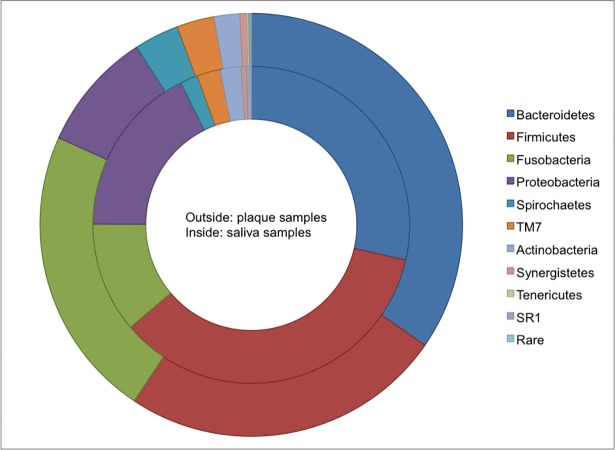
Comparison of the average taxonomy composition distribution at the phylum level in all plaque (outside) and saliva (inside) samples.GN02, Elusimicrobia, Chloroflexi and Cyanobacteria have been classified as 'Other' due to low abundance levels <0.1%.